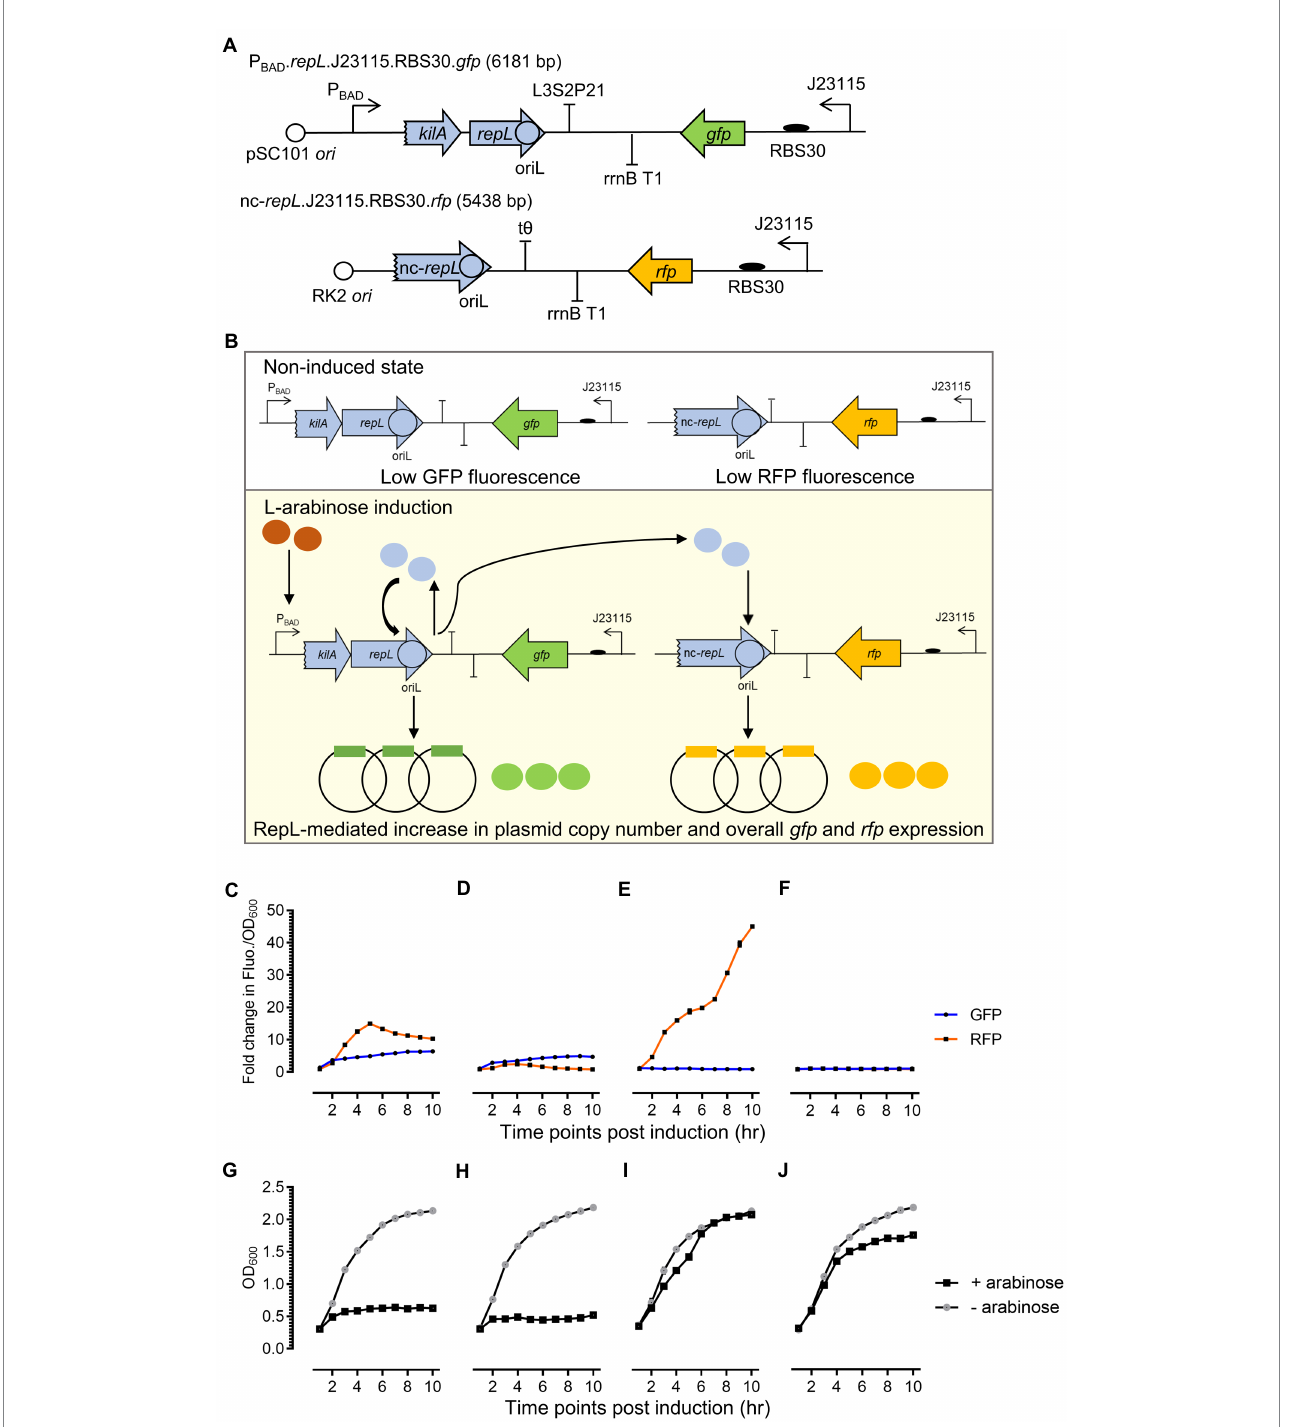
FIGURE 4 A repL AT2 allele reduced the cis -acting RepL-mediated signal amplification while retaining the ability of its protein product to increase the output of a rfp plasmid in trans . (A) Schematic diagram of the rfp reporter construct. A repL gene sequence truncated by 40 bp at its 5 ′ -end, was assembled in a rfp - encoding reporter plasmid. This non-protein coding repL gene, termed nc- repL , would only serve as a target site for RepL provided in trans . Rfp (in orange) was constitutively expressed under a weak constitutive promoter, Bba_J23115, with an artificial ribosomal binding site, RBS30. The rfp. nc- repL plasmid confers kanamycin resistance and has a RK2 oriV conferring low plasmid copy number. (B) Schematic diagram of RepL-mediated DNA replication in cis and in trans . Upon L-arabinose induction of repL gene expression, the protein product would target the oriL within its own gene sequence ( in cis ) as well as one within the nc- repL sequence ( in trans ). This would lead to an increase in the copy number of both reporter plasmids and therefore, giving an increase in GFP and RFP output compared to uninduced state. Fold changes in GFP (in blue) and RFP (in orange) fluorescence intensity per OD 600 (Fluo./OD 600 ) values of TOP10 transformed with (C) gfp.repL WT and rfp .nc- repL WT plasmids, (D) gfp.repL WT . and rfp .nc- repL AT2 reporter plasmids, (E) gfp.repL AT2 and rfp. nc- repL WT reporter plasmids, or (F) gfp.repL AT2 and rfp. nc- repL AT2 reporter plasmids at 1 to 10 hpi with 1.33 ×10 − 4 M of L-arabinose. The OD 600 of arabinose-induced TOP10 cells (+ arabinose, in black) and uninduced TOP10 cells ( − arabinose, in gray) with (G) gfp.repL WT and rfp .nc- repL WT reporter plasmids, (H) gfp.repL